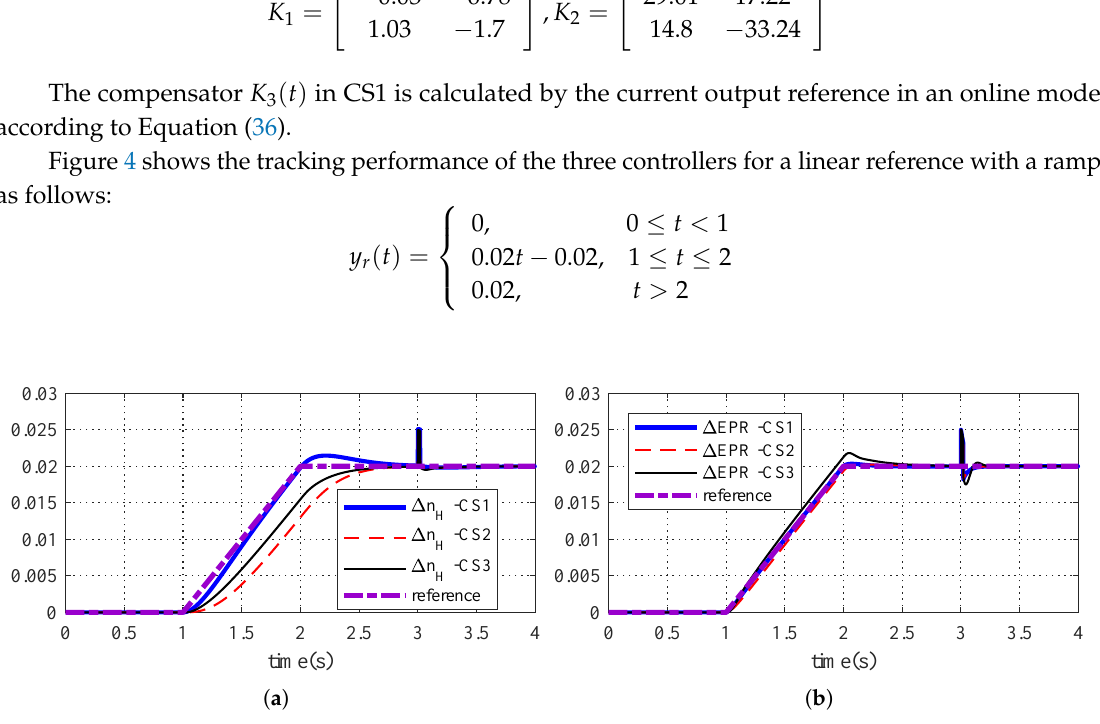
Figure 4. Output response for the ramp reference. ( a ) ∆ n H tracking curve; ( b ) ∆ EPR tracking